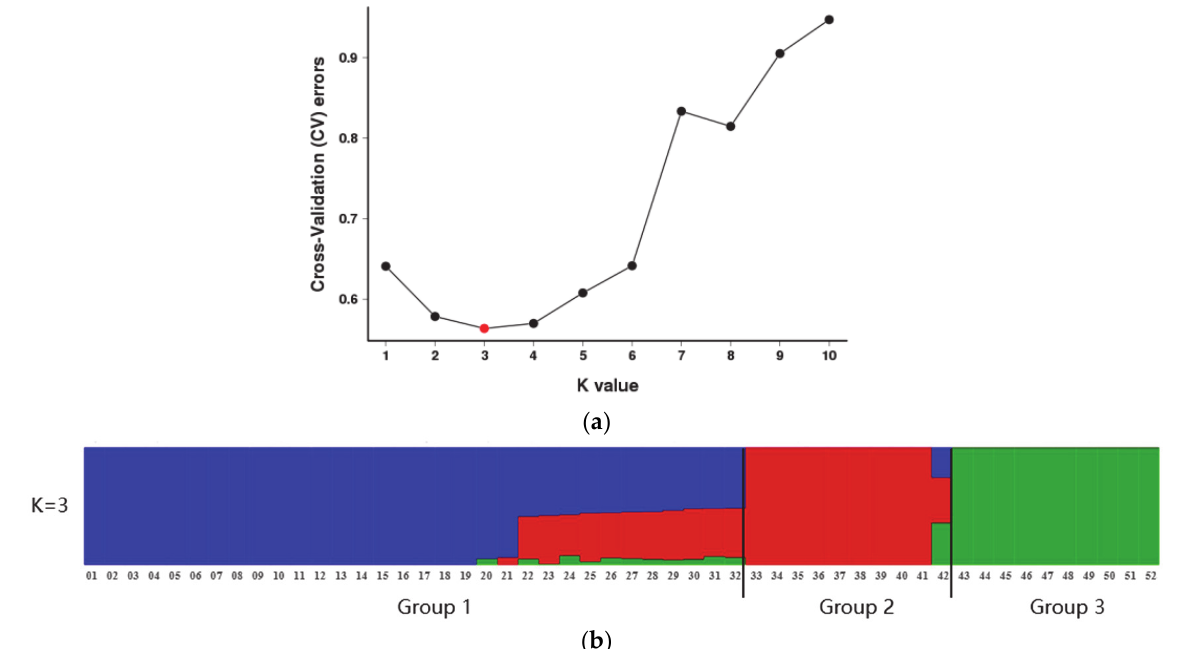
Figure 2. P. bungeana genetic structure. ( a ) Estimation of the optimal number of clusters, defined by the Evanno method; ( b ) The proportion of ancestry for each individual (K = 3). Each vertical bar corresponds to an individual, and different colors represent inferred genetic clusters. Segments of each vertical line show extent of admixture in an individual.